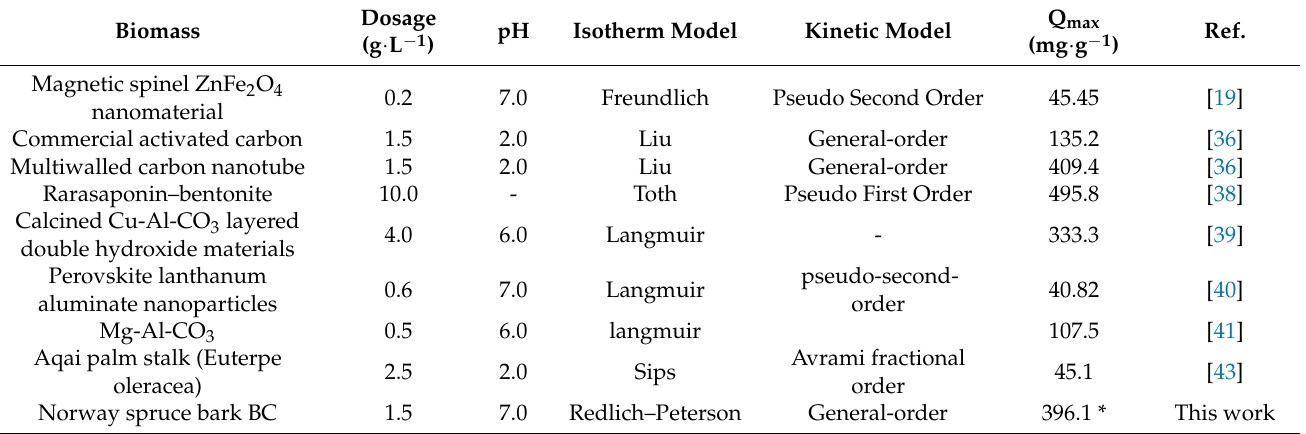
Table 6. Comparison of EB adsorption capacity on Norway spruce bark BC and other parameters obtained from the different materials reported in the